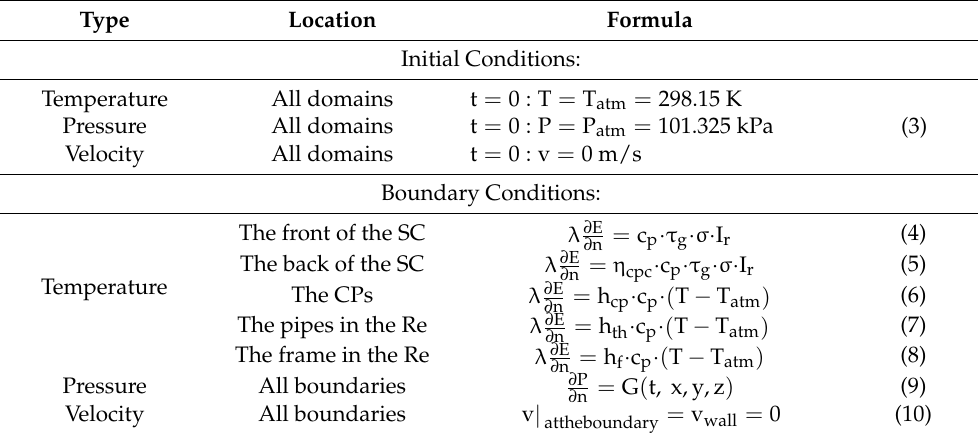
Table 3. Initial conditions and boundary conditions in the